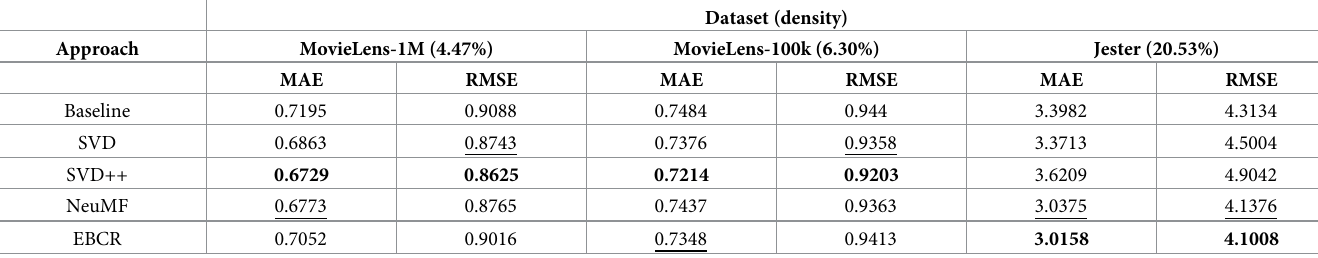
Table 3. Comparisons of EBCR vs. model-based collaborative filtering approaches.